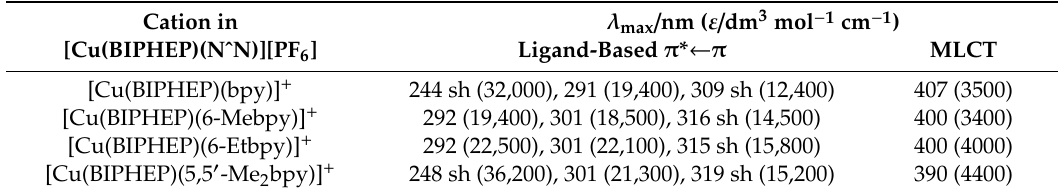
Figure 8. Solution absorption spectra of the [Cu(BIPHEP)(NˆN)][PF 6 ] complexes (CH 2 Cl 2 , 3.5–5.3 × 10 − 5 mol dm − 3 ). Table 3. Solution absorption maxima for the [Cu(BIPHEP)(NˆN)][PF 6 ] complexes (CH 2 Cl 2 with